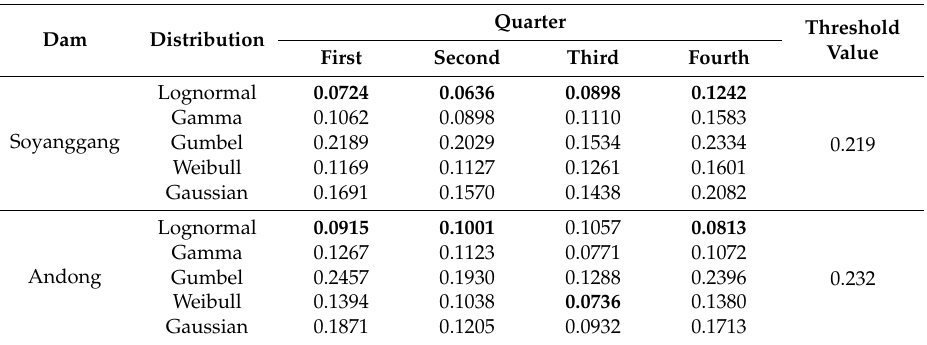
Figure 8. Histogram against the five distributions of the quarterly inflow volumes of the Andong dam during the training period of 1977–2010: ( a ) first quarter; ( b ) second quarter; ( c ) third quarter; ( d ) fourth quarter. Table 3. The D n value of the K–S test.